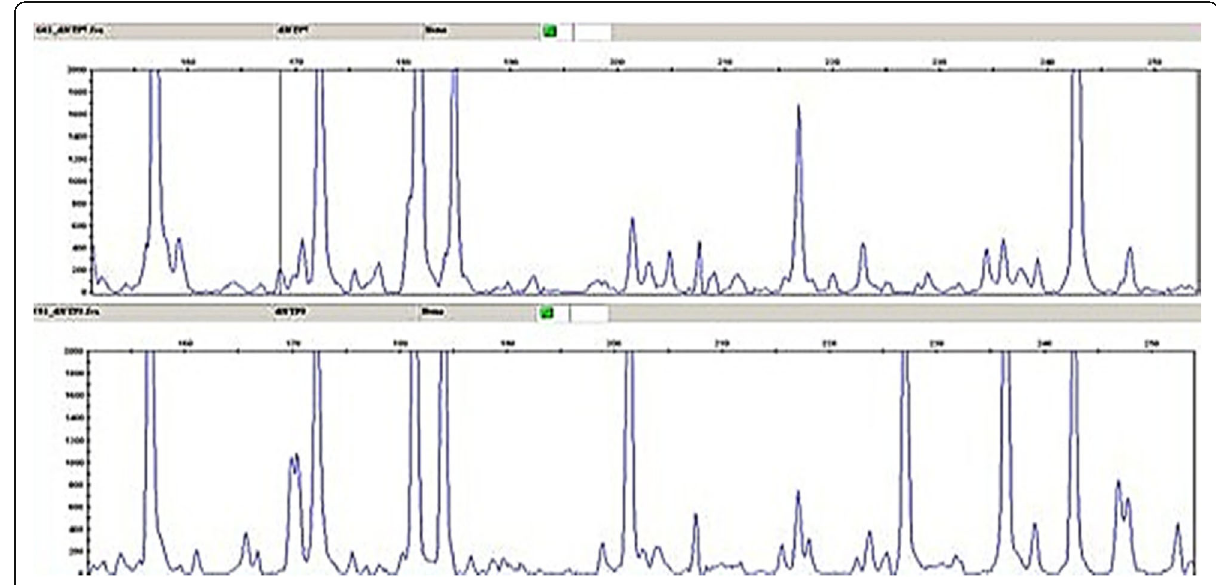
Fig. 3 AFLP electropherograms obtained with the primers Pst l + ATC and Mse l + Fluro (FAM). The duplicated population (Fle13) was coming from the same DNA sample and showing different alleles (peaks), which are unidentified